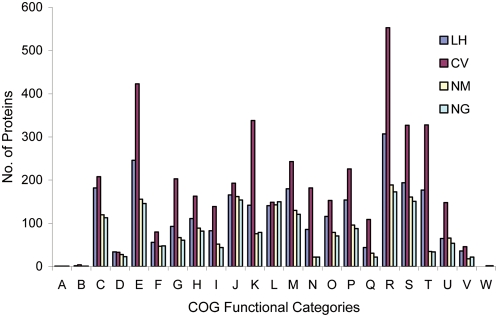
Coding sequence function distribution in genomes of L. hongkongensis, C. violaceum, N. meningitidis and N. gonorrhoeae.The columns indicate the number of proteins in different Cluster of Orthologous Groups (COG) functional categories (www.ncbi.nlm.nih.gov/COG). LH, L. hongkongensis; CV, C. violaceum; NM, N. meningitidis, NG, N. gonorrhoeae.